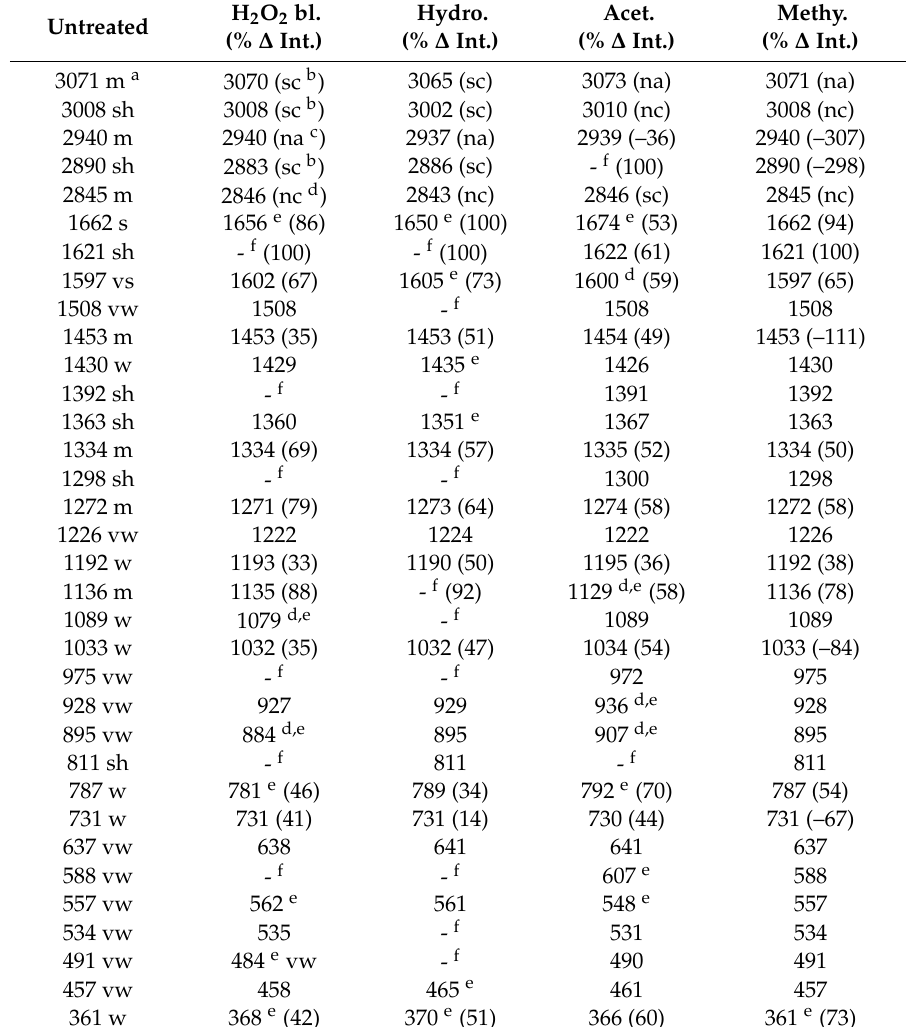
Table 1. Treated black spruce milled-wood lignins (MWLs)—Raman frequencies (cm –1 ) and change in peak-intensity of most intense untreated MWL bands. Reproduced with permission from Ref. [45]. Copyright TAYLOR & FRANCIS